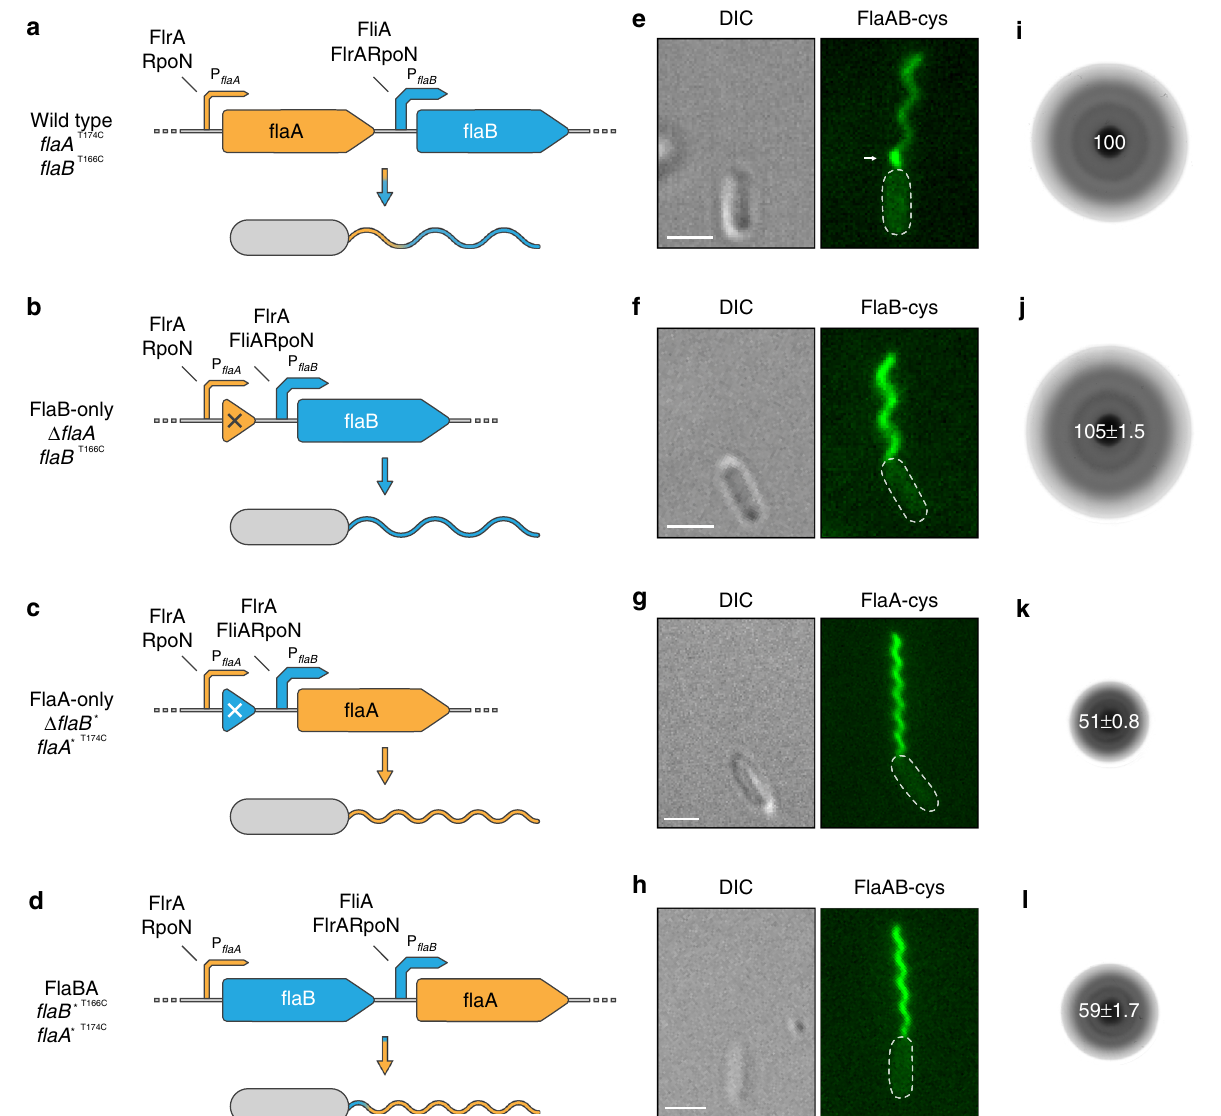
Fig. 1 Overview of the different types of polar fl agellar fi laments constructed in this study. In all strains the genes for the lateral fl agellins were deleted. a – d Genetic organization of the polar fl agellins and genetic modi fi cations to obtain different fi lament types. In the wild-type context fl aA lies upstream of fl aB and transcription is controlled by a FliA-independent promoter (cp. Supplementary Fig. 2b). In contrast, transcription of fl aB is controlled by a stronger, FliA-dependent promoter and mediates production of the major part of the fl agellar fi lament. Expression of both genes relies on RpoN and FlrA. A functional fi lament is only produced when at least one of the fl agellar genes is expressed from the fl aB promoter. If no fl agellin is expressed from the fl aB promoter only short fi lament stubs are formed (see Supplementary Fig. 5). Gene deletions are marked with a cross, swapping of the fl agellin gene sequences is marked with an asterisk. P fl aA / B = fl aA / B promoter. e – h Micrographs of cells with fl uorescently labeled fl agellar fi laments displaying the outcome of the genetic editing of the fl agellin genes. Panel e also shows the spatial distribution of the fl agellins FlaA and FlaB in the wild-type fi lament (see also Supplementary Fig. 4). The FlaA portion is marked with an arrow. The increased fl uorescence of FlaA compared to that of FlaB is likely due to a better accessibility of the cysteine residue during the fl uorescent labeling process. Scale bars represent 2 µ m. i – l Radial expansion of cells with different types of fl agellar fi laments in 0.25% soft agar. Wild-type and FlaB-only cells spread well in this structured environment while the spreading ability of FlaA-only and FlaBA cells is strongly impaired. The numbers in the center of the colonies indicate the relative spreading compared to the wild type in percent (% ± s.d.) of three individual